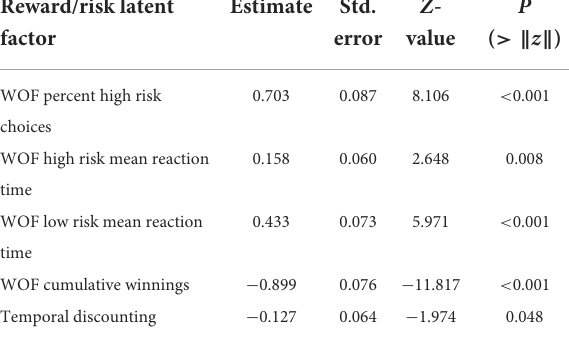
TABLE 3 Normalized estimates for latent factors estimated with confirmatory factor analysis summarizing reward/risk-taking in the Wheel of Fortune Gambling and Temporal Delay Discounting